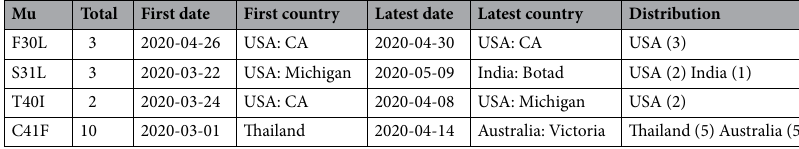
Table 7. Gene ORF7b—nonsynonymous mutations occurring in 2 or more sequences.